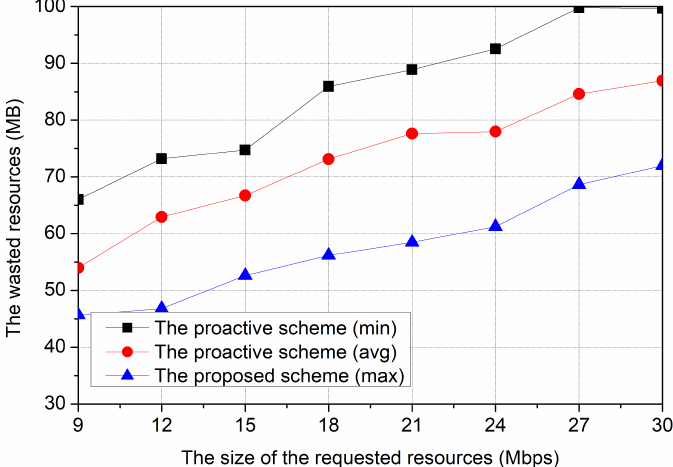
Figure 6. The wasted resources for the size of the requested